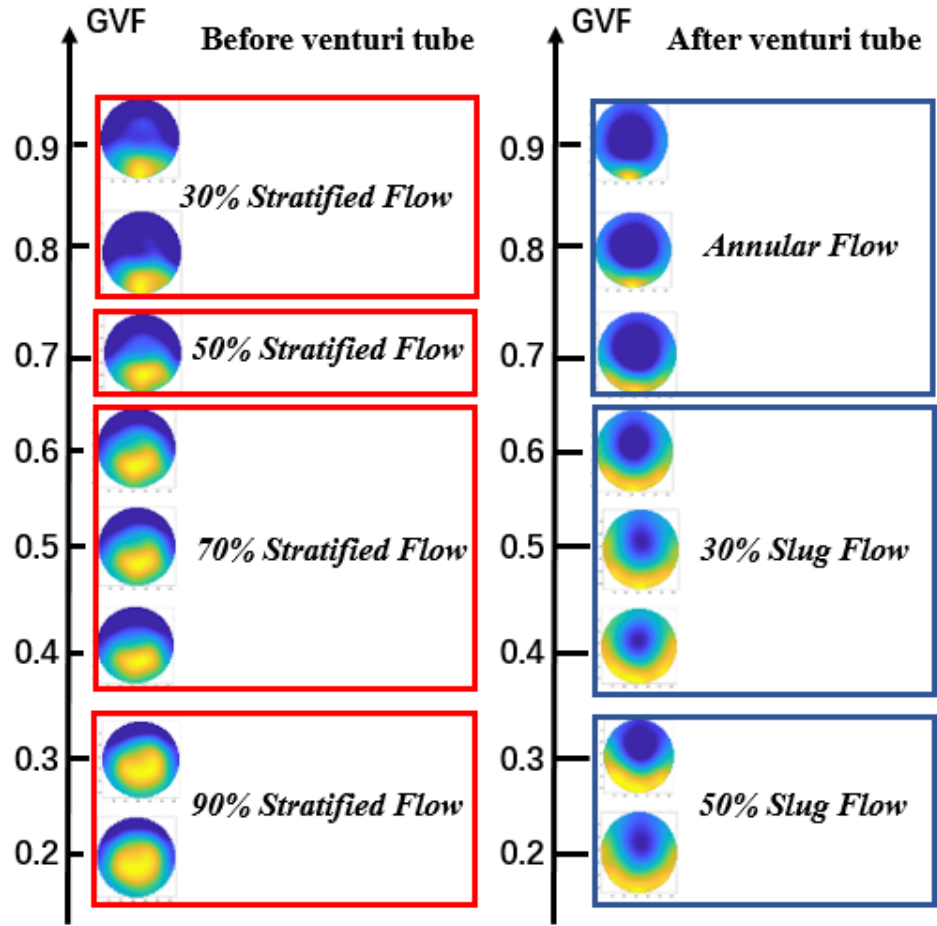
Figure 4. Flow pattern diagram under typical gas void fraction (GVF).